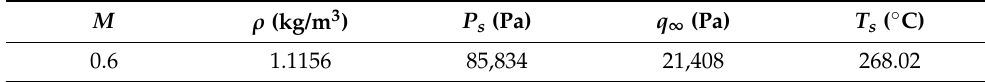
Table 1. Parameters of the FD-12 wind tunnel.